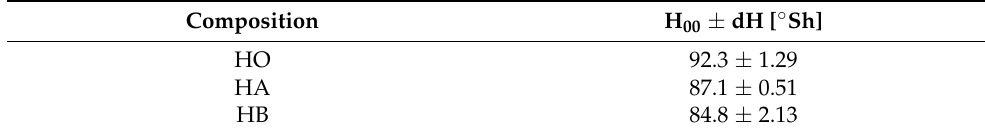
Table 1. Shore 00 hardness measurements with the standard deviation.